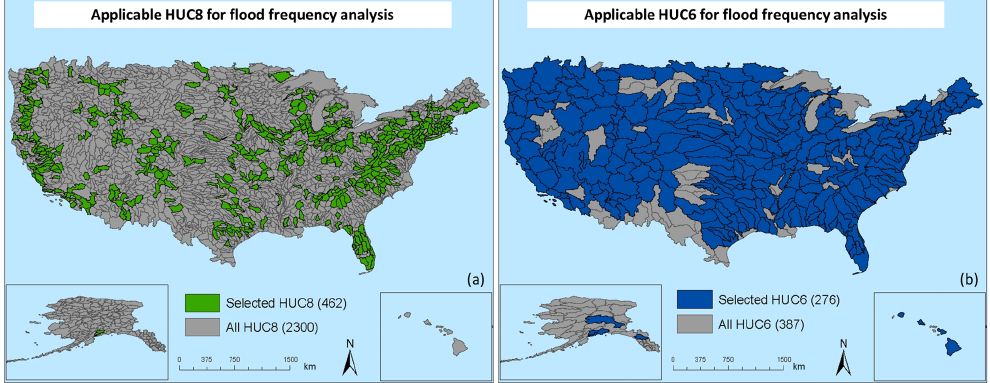
Figure 1. A map of the selected HUC8 and